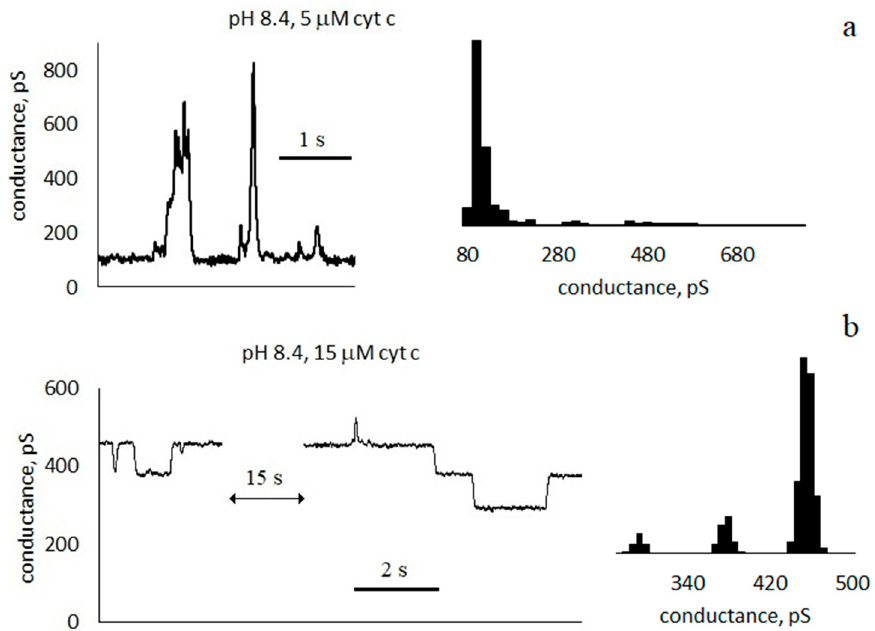
Figure 4. Conductance traces and histograms of asolectin membranes with symmetrical addition of cyt c at pH 8.4: ( a ) 5 µM, and ( b ) 15 µM; 0.1 M KCl, 20 ms averaging.